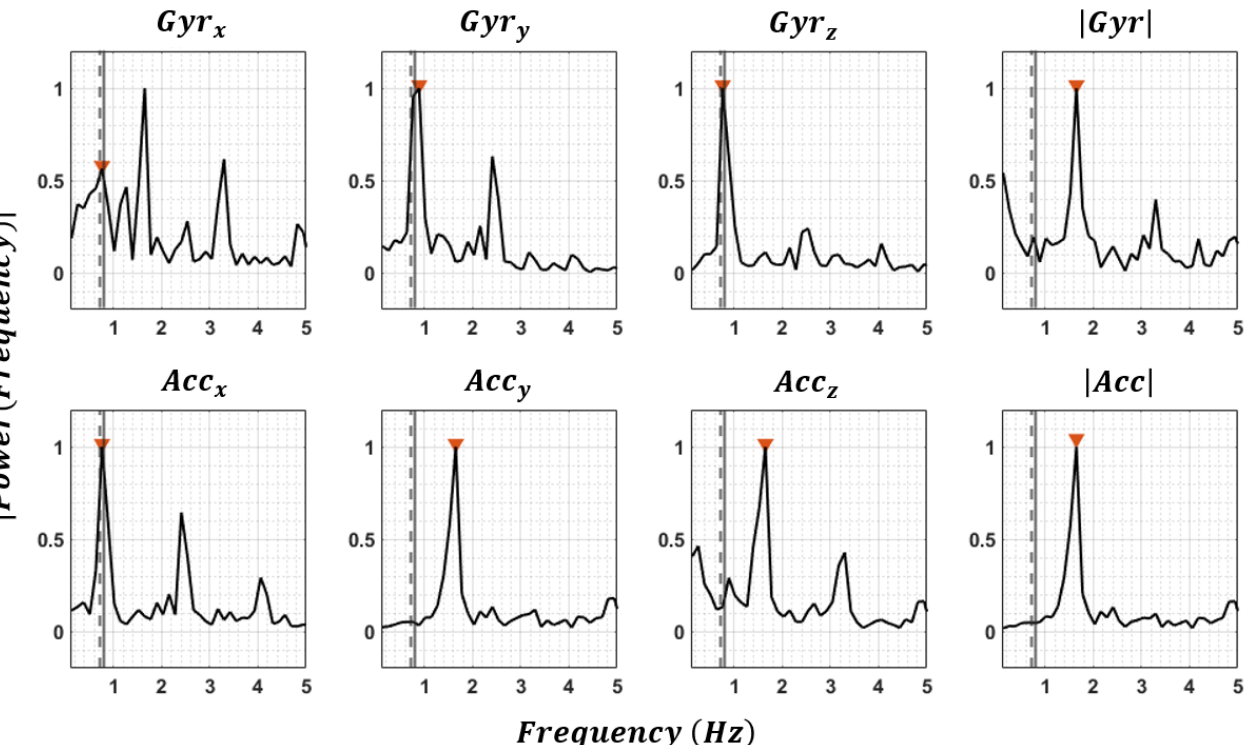
Figure 4. Fast Fourier transform of the gyroscope and accelerometer signals for one walking bout of a healthy subject for the trunk sensor. The first estimates of the stride time corresponding to the first peak in the frequency spectrum with a minimum amplitude of 0.5 are indicated by . The dotted vertical line shows the second estimate of stride time obtained through Equation (1). The solid ver- tical line indicates the measured stride time using the instrumented insole. In this case, the first estimates of stride time ( ) extracted from Gyr x , Gyr z , and Acc x were similar and had a minimum absolute difference with the second estimate (dotted line), so it was considered as the mean stride time of this walking bout.